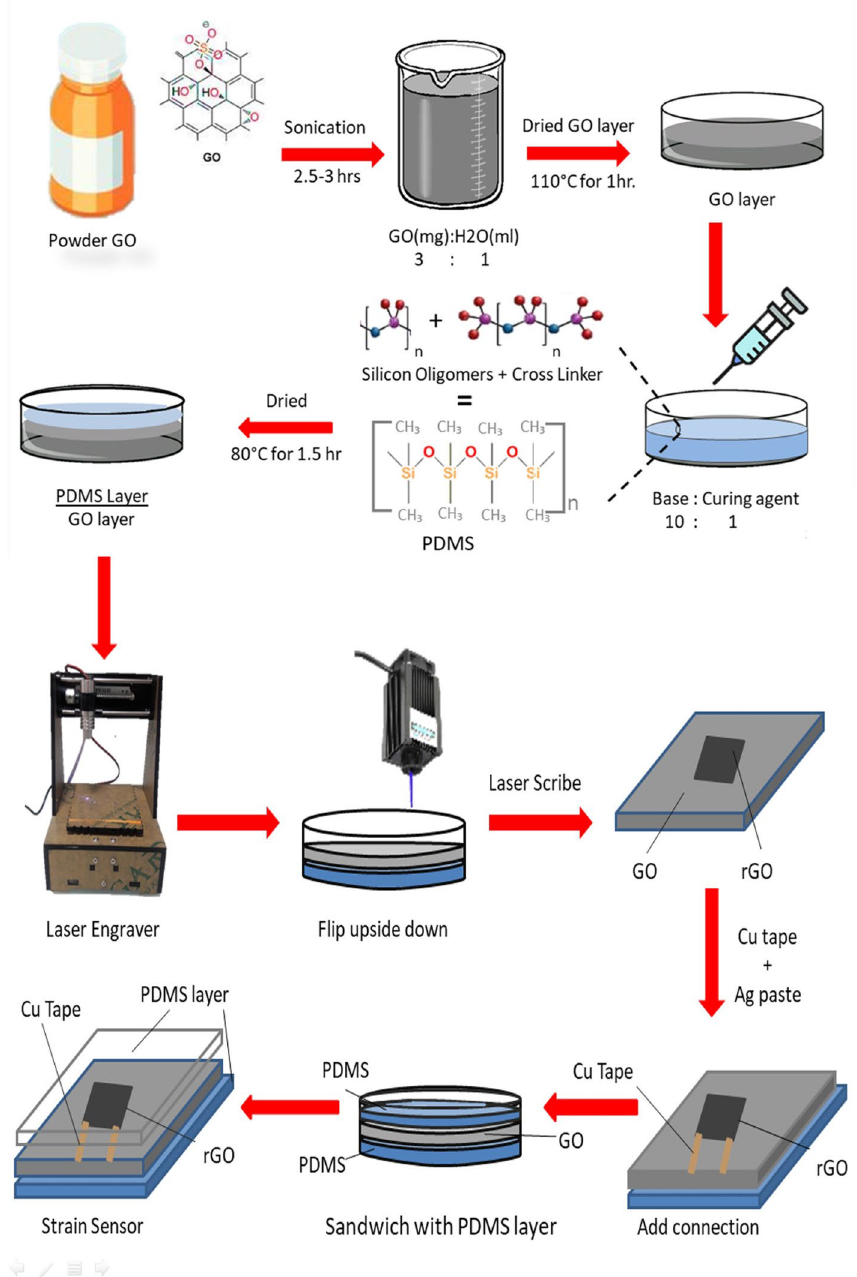
Figure 1. Schematic illustration of the fabrication of a strain sensor composed of laser scribed rGO and PDMS. The process includes synthesis of GO, adhesion with PDMS, laser patterning (reduction) of rGO/PDMS stack, lead-out, and sandwiching the structure in PDMS. (Chemical structures were drawn using Chem Draw by PerkinElmers Informatics and Images were drawn using Adobe Illustrator and Microsoft PowerPoint drawing tools and assembling was done using Microsoft PowerPoint while some images were taken from online image gallery 27–29